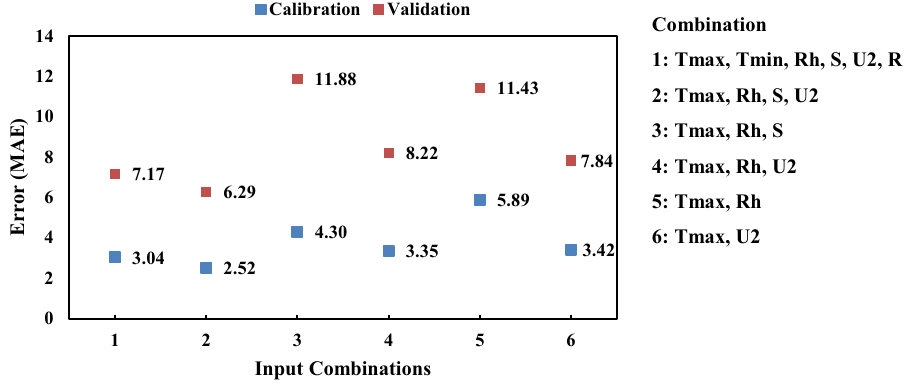
Fig. 7 Comparison of model errors based on different combi- nation of important